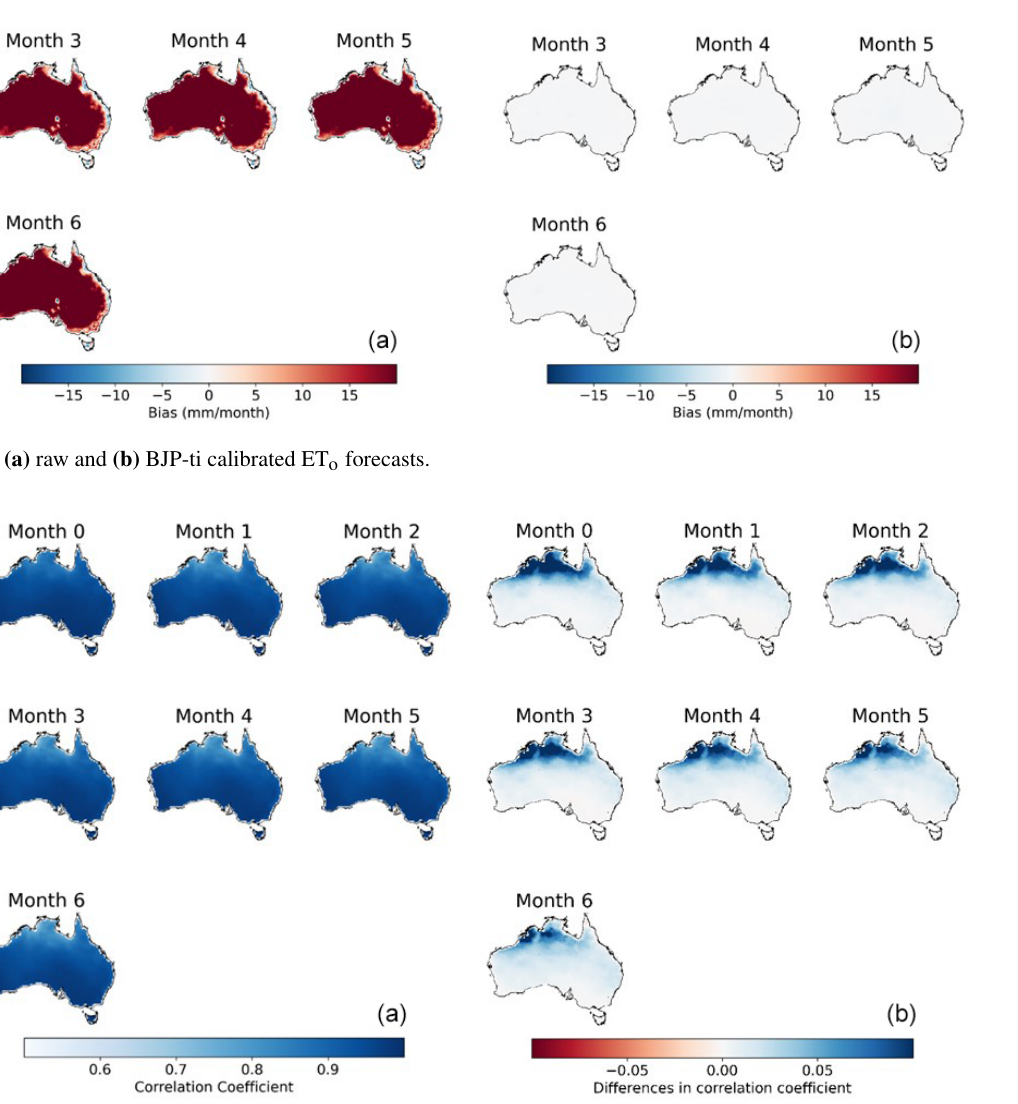
Figure 8. (a) Correlation coefficients between BJP-ti calibrated forecasts and observations and (b) improvements in correlation coefficients through the calibration with the BJP-ti model relative to those between raw forecasts and